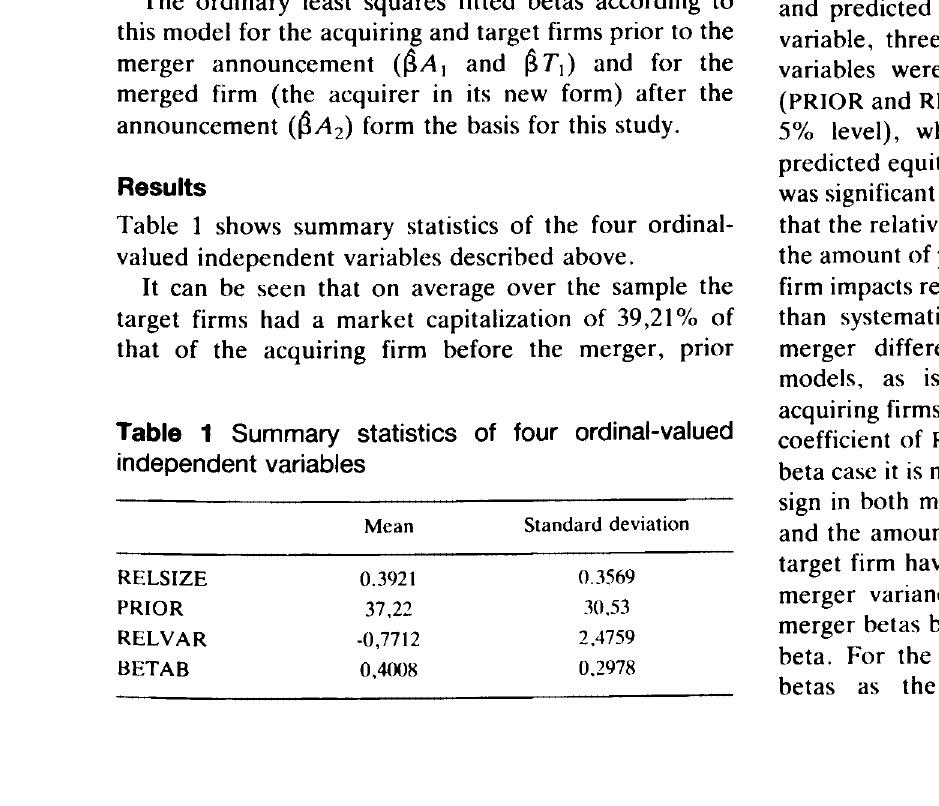
independent variables